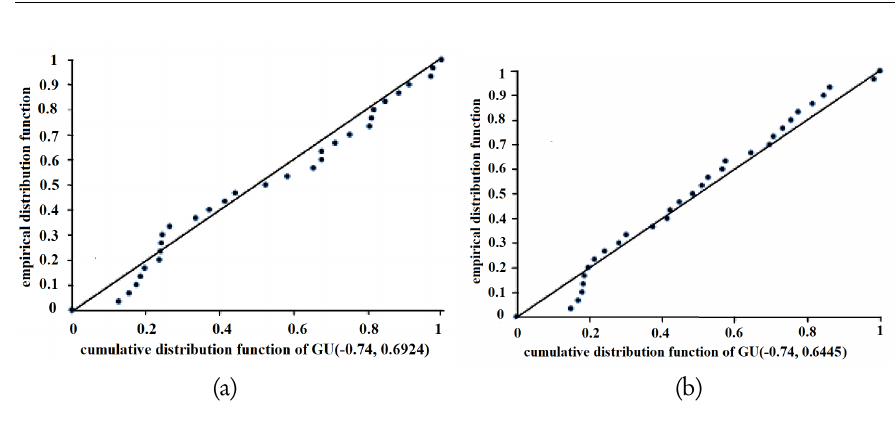
Figure 1 – P-P plots of the transformed data